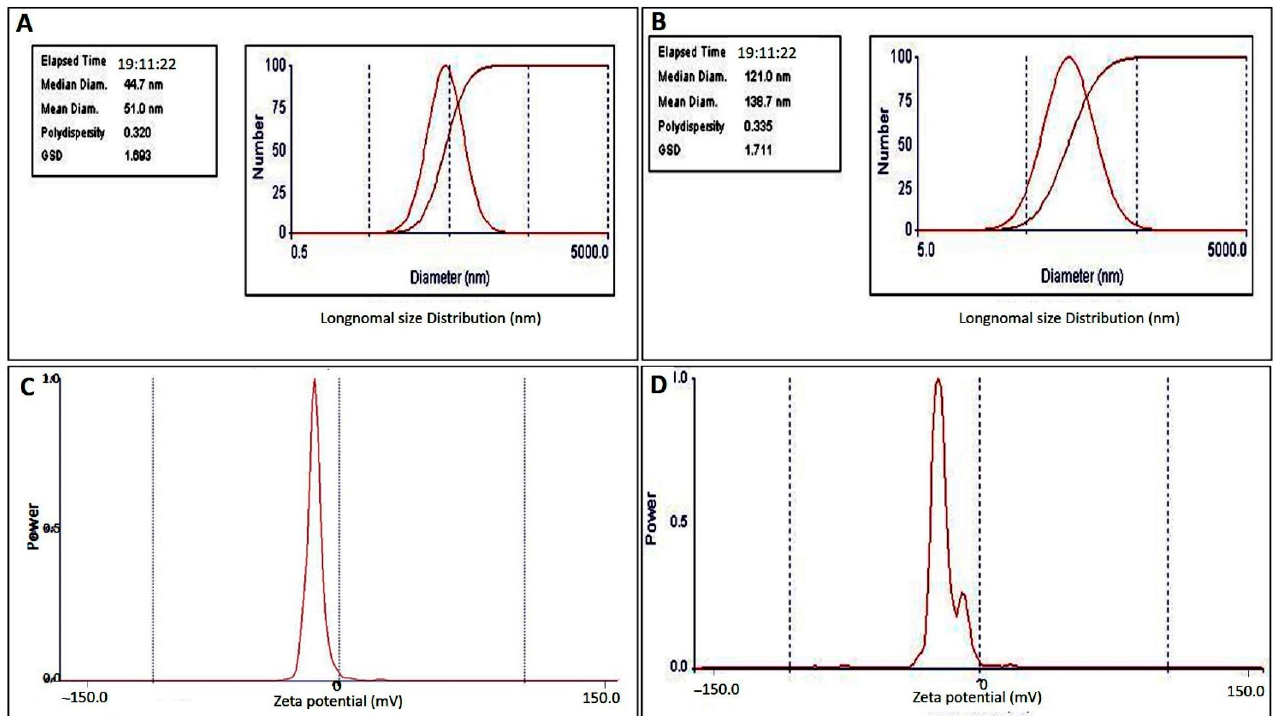
Figure 2. SEM image showing the morphology of EPCIBP. ( A ) SEM image of EPCIBP showing na- noparticles with spherical shapes; ( B ) magnification image of EPCIBP; ( C ) quantification analysis of diameter of nanoparticles; ( D ) SEM image of EPCIBP showing micro/nanopores; ( E ) grayscale im- age with thresholding observing the micro/nanopores as red color; ( F ) quantification analysis of micro/nanopores distributed in the matrix; ( G ) SEM image of free capsules showing nanoparticles with spherical shape; ( H ) magnification image of free capsules; ( I ) quantification analysis of diame- ter of nanoparticles.